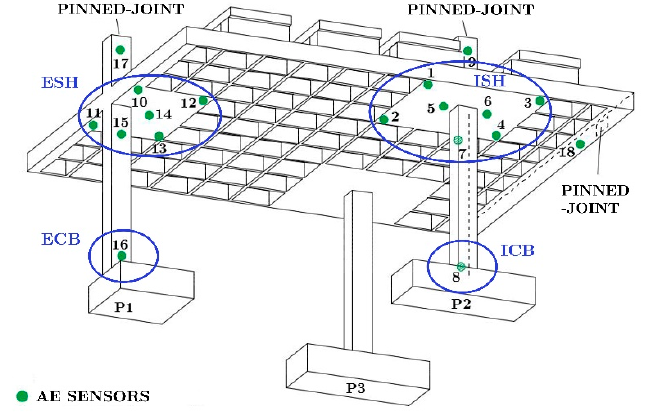
Figure 5. Sensitivity curve of sensor VS30-V. 163